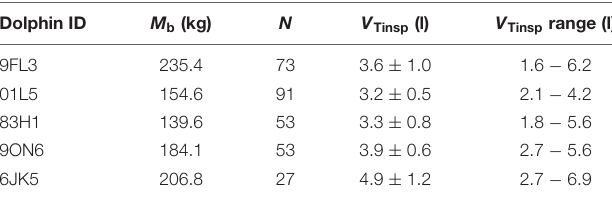
TABLE 1 | Dolphin ID, body mass ( M b ), total number of breaths analyzed (N), average ( ± SD) tidal volume ( V Tinsp ), and V Tinsp range. Dolphin